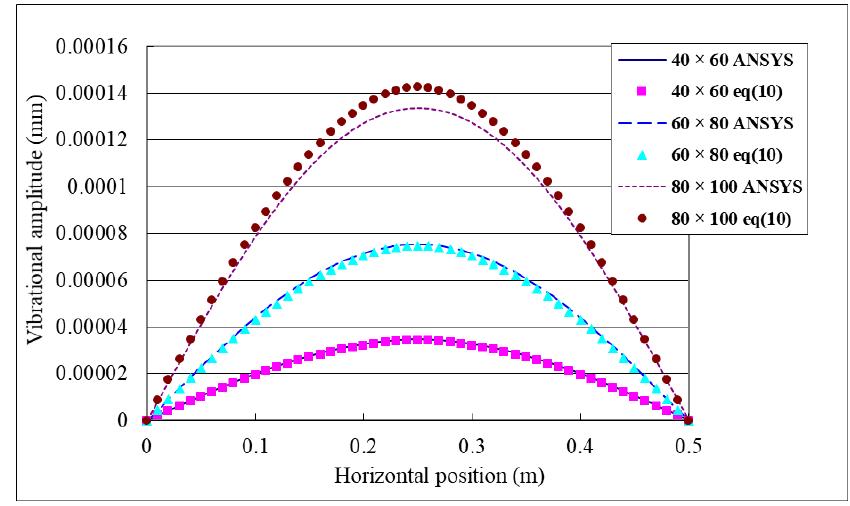
Figure 6. Vibrational amplitude distribution along the horizontal line (y = 0.25 m) of the composite laminate plate excited by PZT actuators with three different sizes.